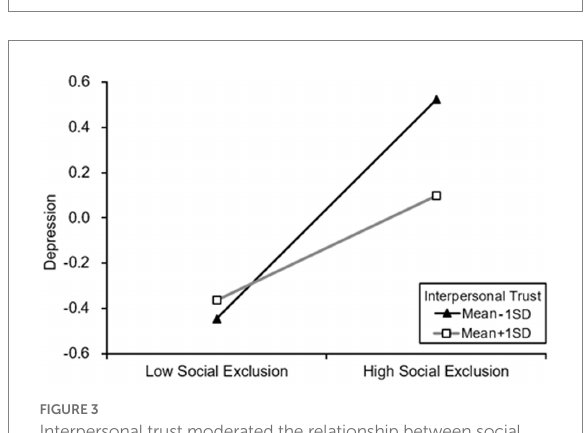
FIGURE 3 Interpersonal trust moderated the relationship between social exclusion on